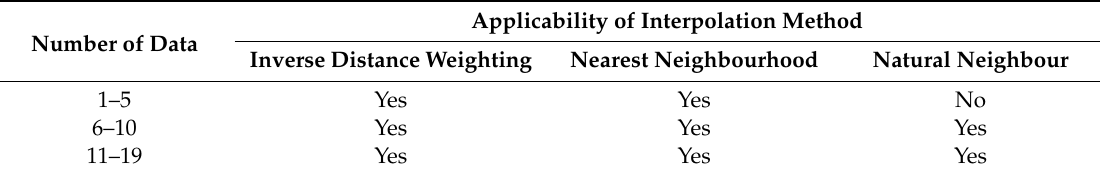
Table 4. Recommended interpolation methods for small input data